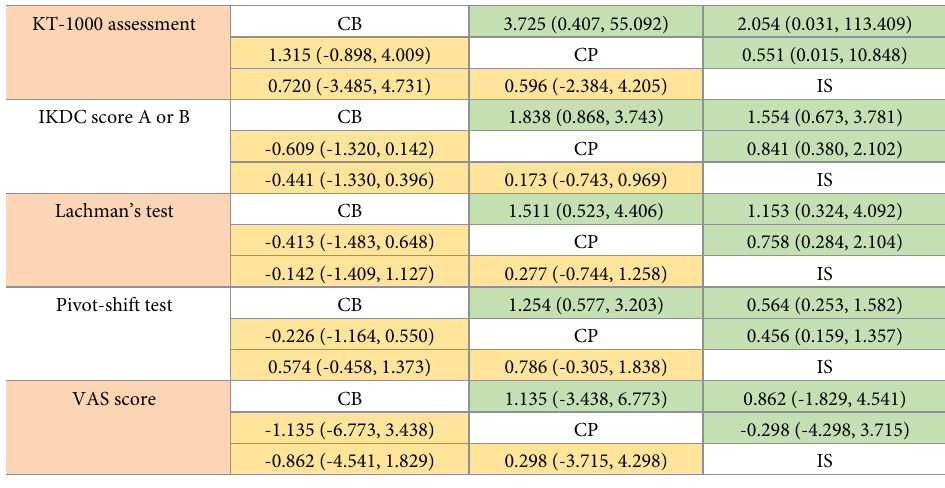
test. CP and CB (CP vs CB: pooled OR = 1.200, 95% CrI = 0.390–3.300), IS and CB (IS vs CB: pooled OR = 0.670, 95% CrI = 0.250–2.700), and IS and CP (IS vs CP: pooled OR = 0.310, 95% CrI = 0.036–1.700) also had similar impacts on pivot-shift test. In terms of VAS score, IS did not significantly differ from CB (IS vs CB: pooled SMD = 0.860, 95% CrI = -1.800–4.500) and CP (IS vs CP: pooled SMD = -0.300, 95% CrI = -4.300–3.700). Three studies reported on Lysholm score, and combined analysis revealed that CB presented similar efficacy to CP (CB vs CP: pooled OR = 1.220, 95% confidence interval (CI) = 0.460–3.240, P = 0.686). When reconstruction failures were taken into consideration, the comprehensive analysis of 2 studies indicated that there was no statistical difference between CB and CP (CB vs CP: pooled OR = 1.010, 95% CI = 0.390–2.670, P = 0.977). Fixation methods for single or double bundle ACL reconstruction For KT-1000 assessment, only one study compared CP and IS fixation methods in single bun- dle ACL reconstruction, and no significant difference was found between CP and IS (OR = 0.833, 95% CI = 0.211–3.294, P = 0.795); there was no report on double bundle ACL reconstruction. Regarding IKDC score A or B, CP was shown to have a similar effect to IS in single bundle ACL reconstruction according to a single study (OR = 2.000, 95% CI = 0.525– 7.621, P = 0.310); network meta-analysis was performed for double bundle ACL reconstruc- tion based on 2 studies, and revealed that IS was significantly more effective than CB (pooled Table 4. League tables of fixation methods for various